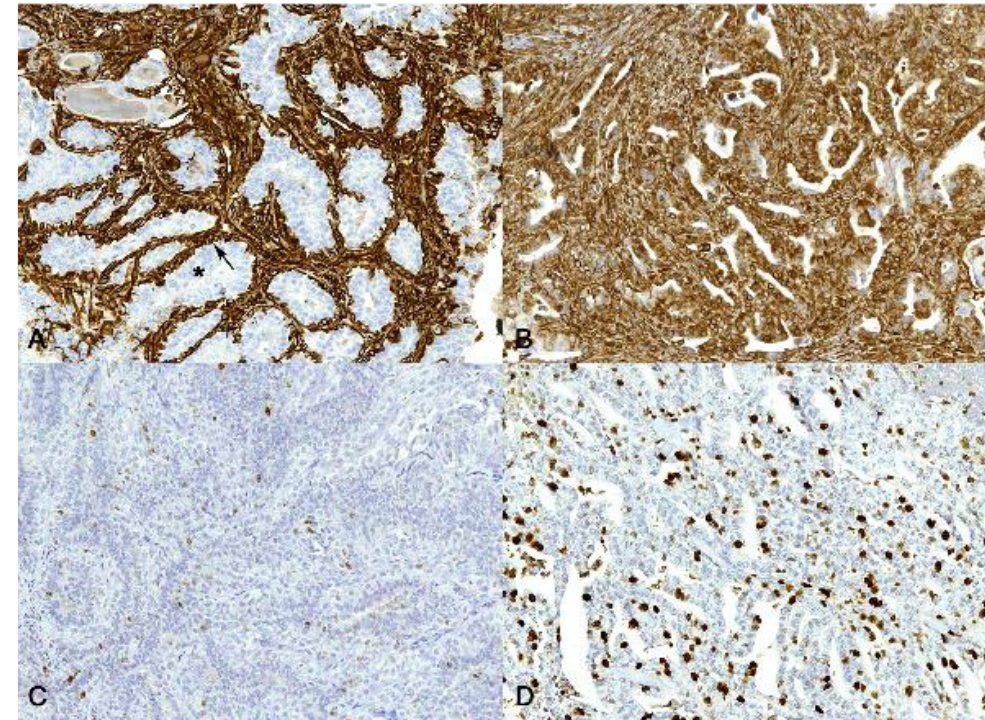
Figure 6. Carcinoma, mammary gland. Immunohistochemistry for vimentin ( A , B ) and Ki-67 ( C , D ). 20 × magnification. ( A ) Canine. Simple carcinoma, grade II. In canine mammary tumors (CMTs), vimentin expression is negative in luminal cells (asterisk) and positive in basal/myoepithelial cells (arrow). ( B ) Feline. Simple carcinoma, grade III. In feline mammary tumors (FMTs), vimentin expression is evident in approximately 90% of tumor cells, including luminal cells. ( C ) Canine. Simple carcinoma, grade I. In CMTs, Ki-67 expression is detectable in approximately 10% of tumor cells. ( D ) Feline. Simple carcinoma, grade III. In FMTs, Ki-67 expression is evident in approximately 40% of tumor cells.